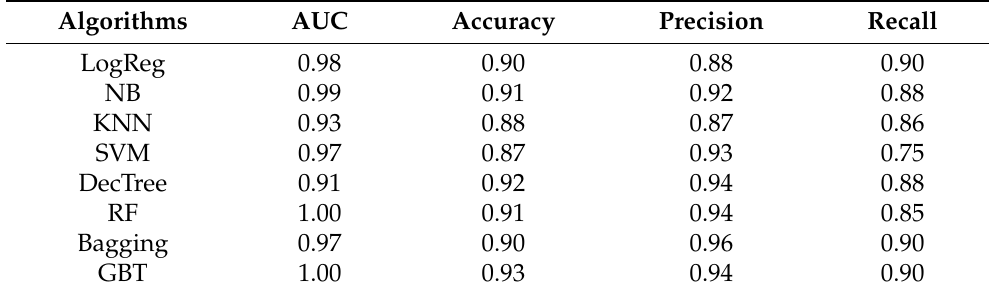
Table 3. Comparison of evaluation metrics for classification algorithm on binary classification.